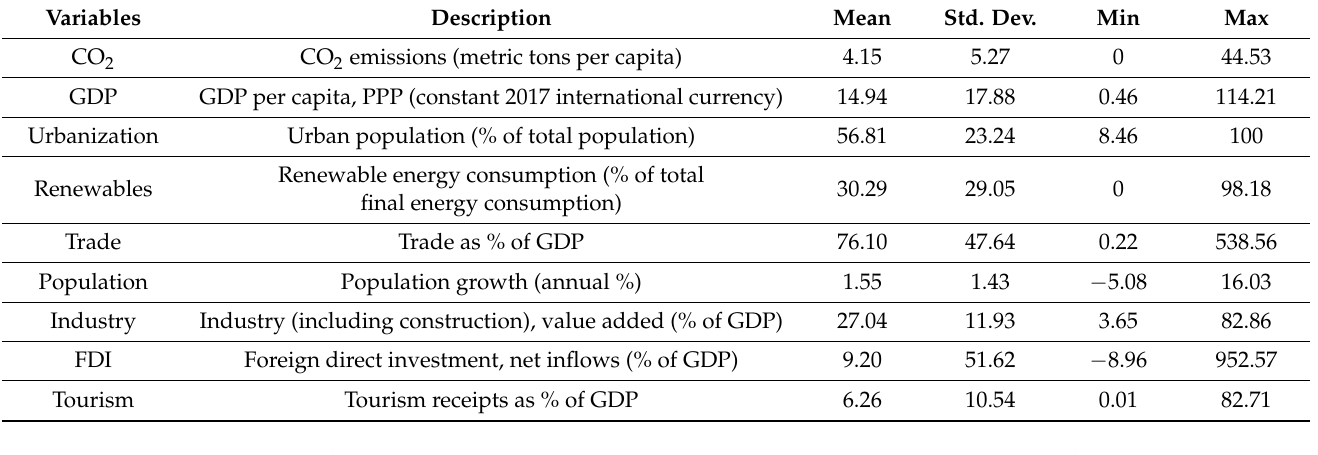
Table 1. Summary statistics.